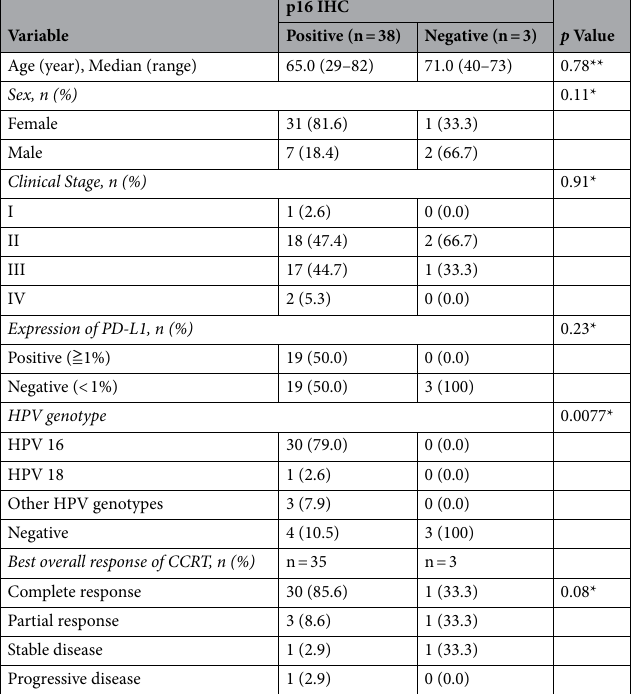
Table 1. Comparison of clinicopathological factors and clinical outcomes according to p16 status. CCRT Concurrent chemoradiation therapy. *Fisher’s exact test, **Mann–Whitney U